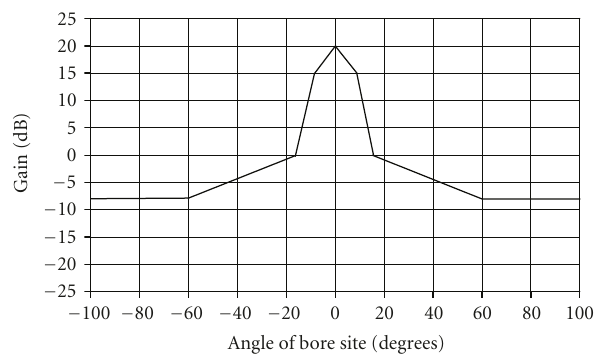
Figure 3: An approximate directional antenna gain function.